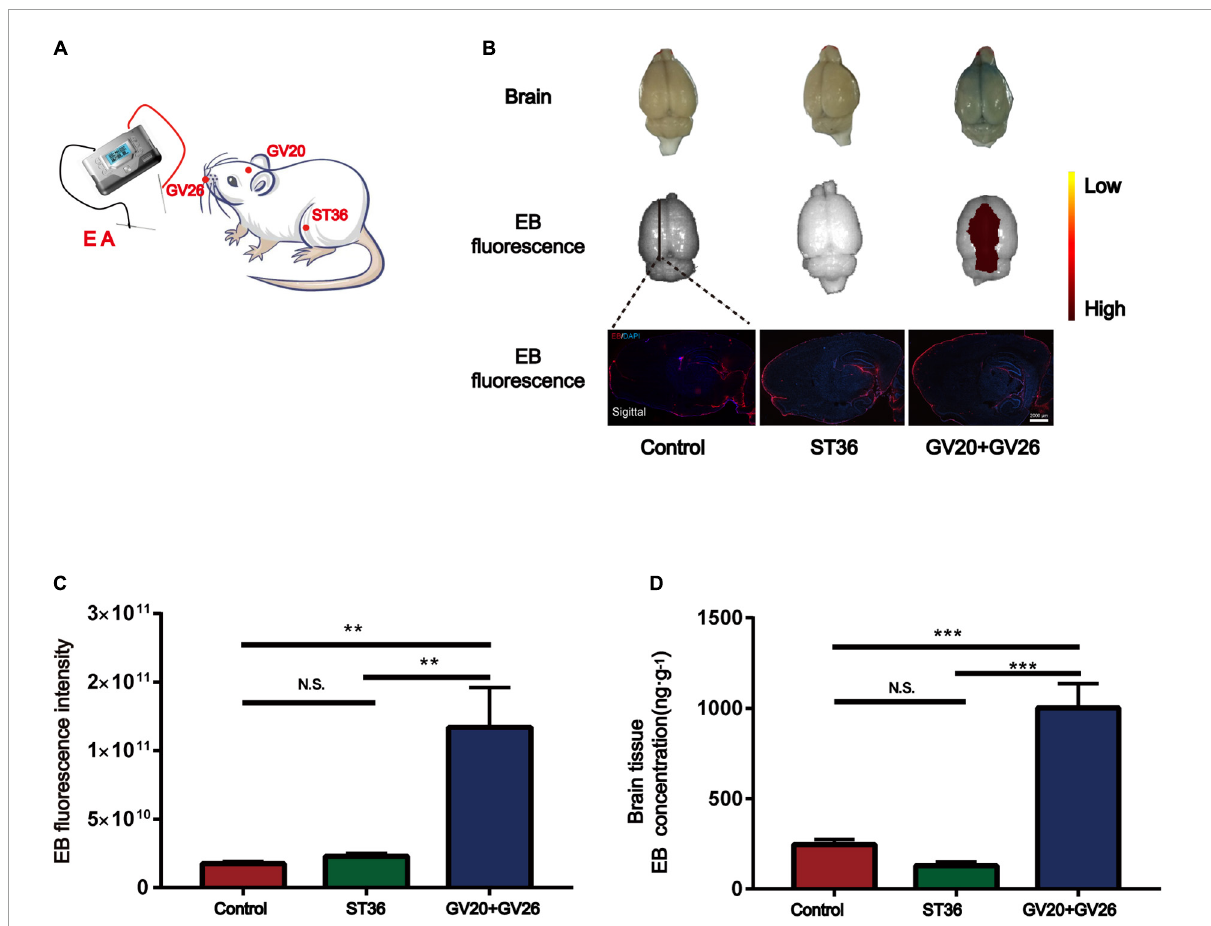
FIGURE1 Electroacupuncture (EA) at the head acupuncture points had a more significant effect on promoting BBB opening than the non-head points. (A) Schematic diagram of EA at different points. (B) The first row shows the degree of brain EB penetration of each group under naked eye observation. Distribution of brain EB in each group was observed using IVIS (Color Scale: Min = 2.25 e 9 , Max = 2.96 e 11 ). The third row shows the fluorescence intensity and distribution of EB in each group under the brain sagittal slice. (C) EB fluorescence intensity of cerebral cortex in each group under IVIS; ** P < 0.01, GV20 + GV26 group vs. control group, ST36 group; P > 0.05, control group vs. ST36 group, n = 6 per group. (D) EB concentration in the cerebral cortex of each group; *** P < 0.001, GV20 + GV26 group vs. control group and ST36 group; P > 0.05, control group vs. ST36 group, n =